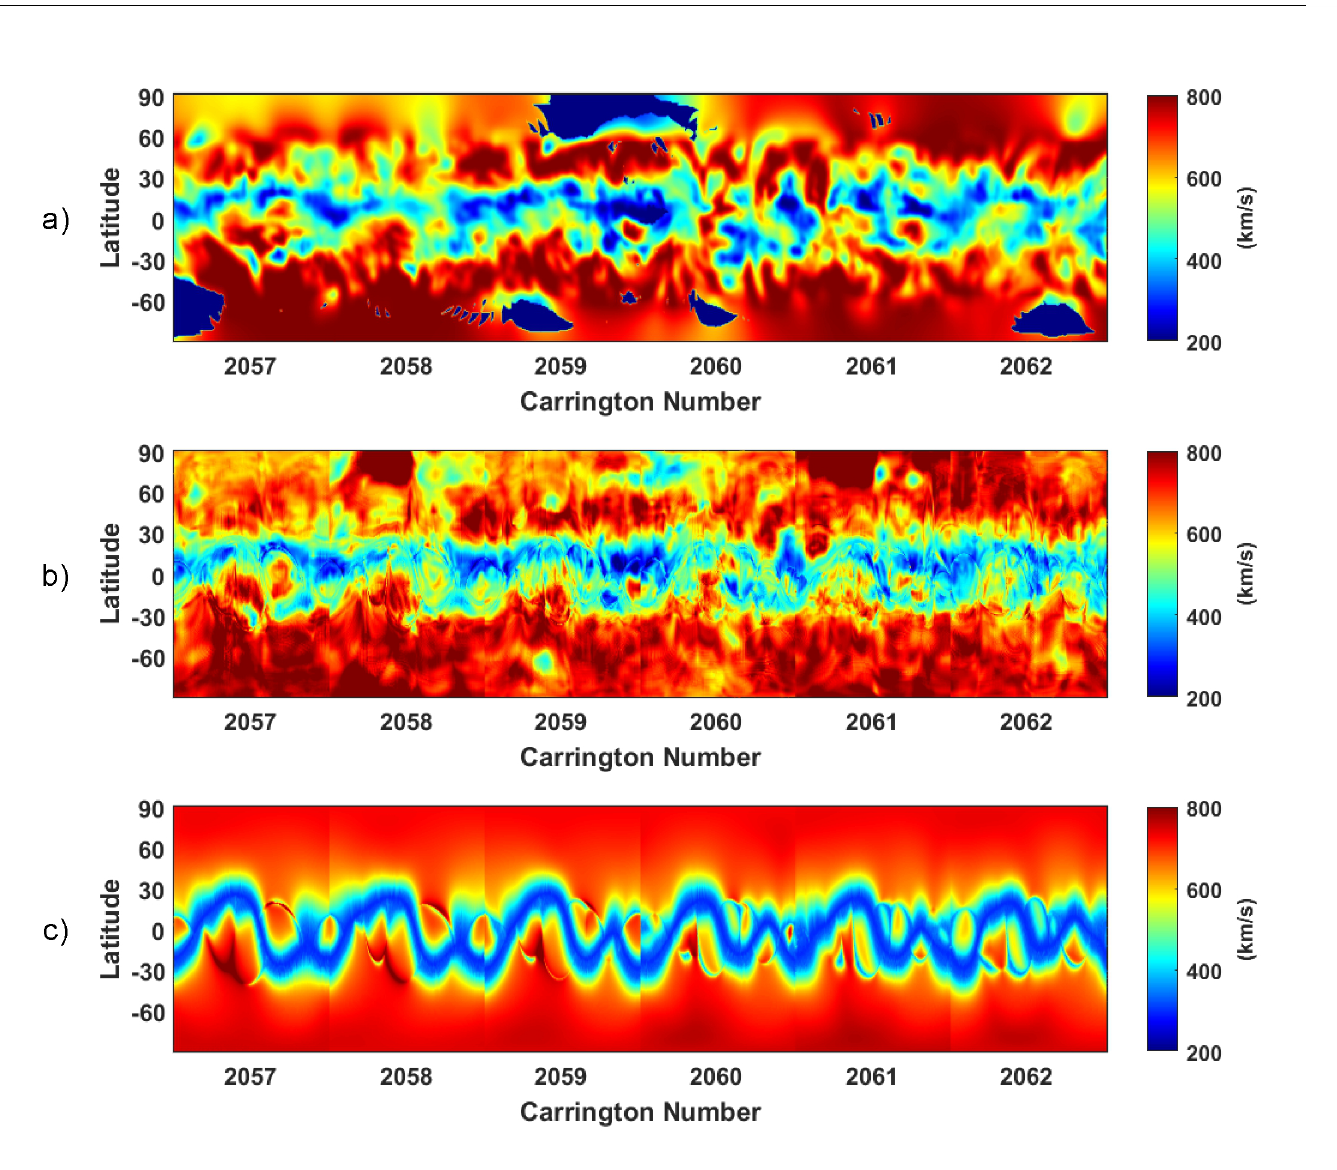
Figure 3. Comparison of the global velocity distribution obtained from the ( a ) IPS observation, ( b ) our ANN model, and ( c ) the WSA model during CR2057 to CR2062. The x axis is the Carrington number, and the y axis is the